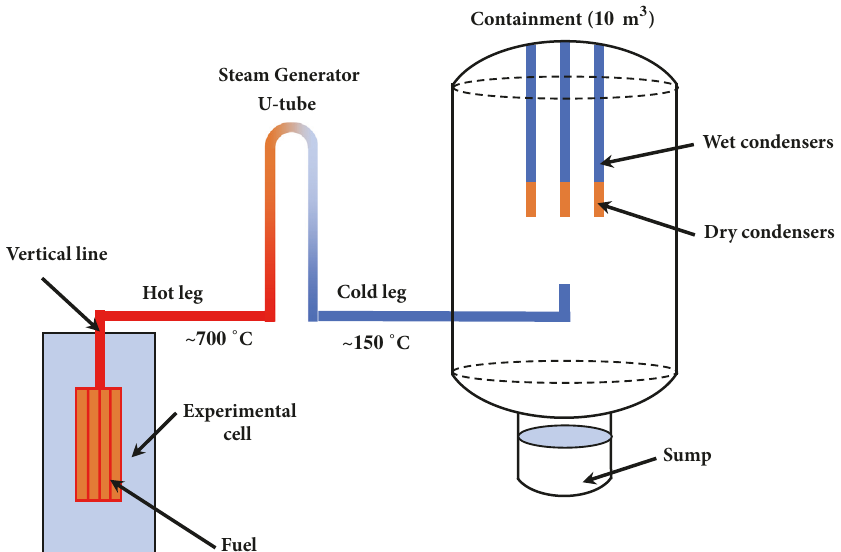
Figure 1: Schematic view of the Ph´ebus FP